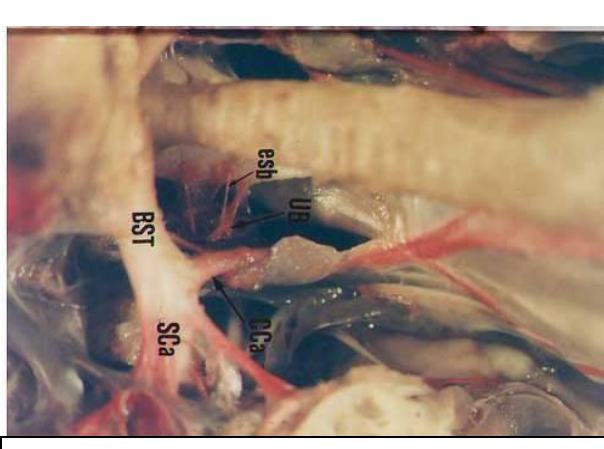
(Fig.7): Photogragh shows the blood supply of ultimobranchial gland in adult geese. Ultimobranchial gland (UB); Brachiocephalic trunk (BCT); Subclavian artery (SCa); Common carotid artery; Esophagus branch (esb).